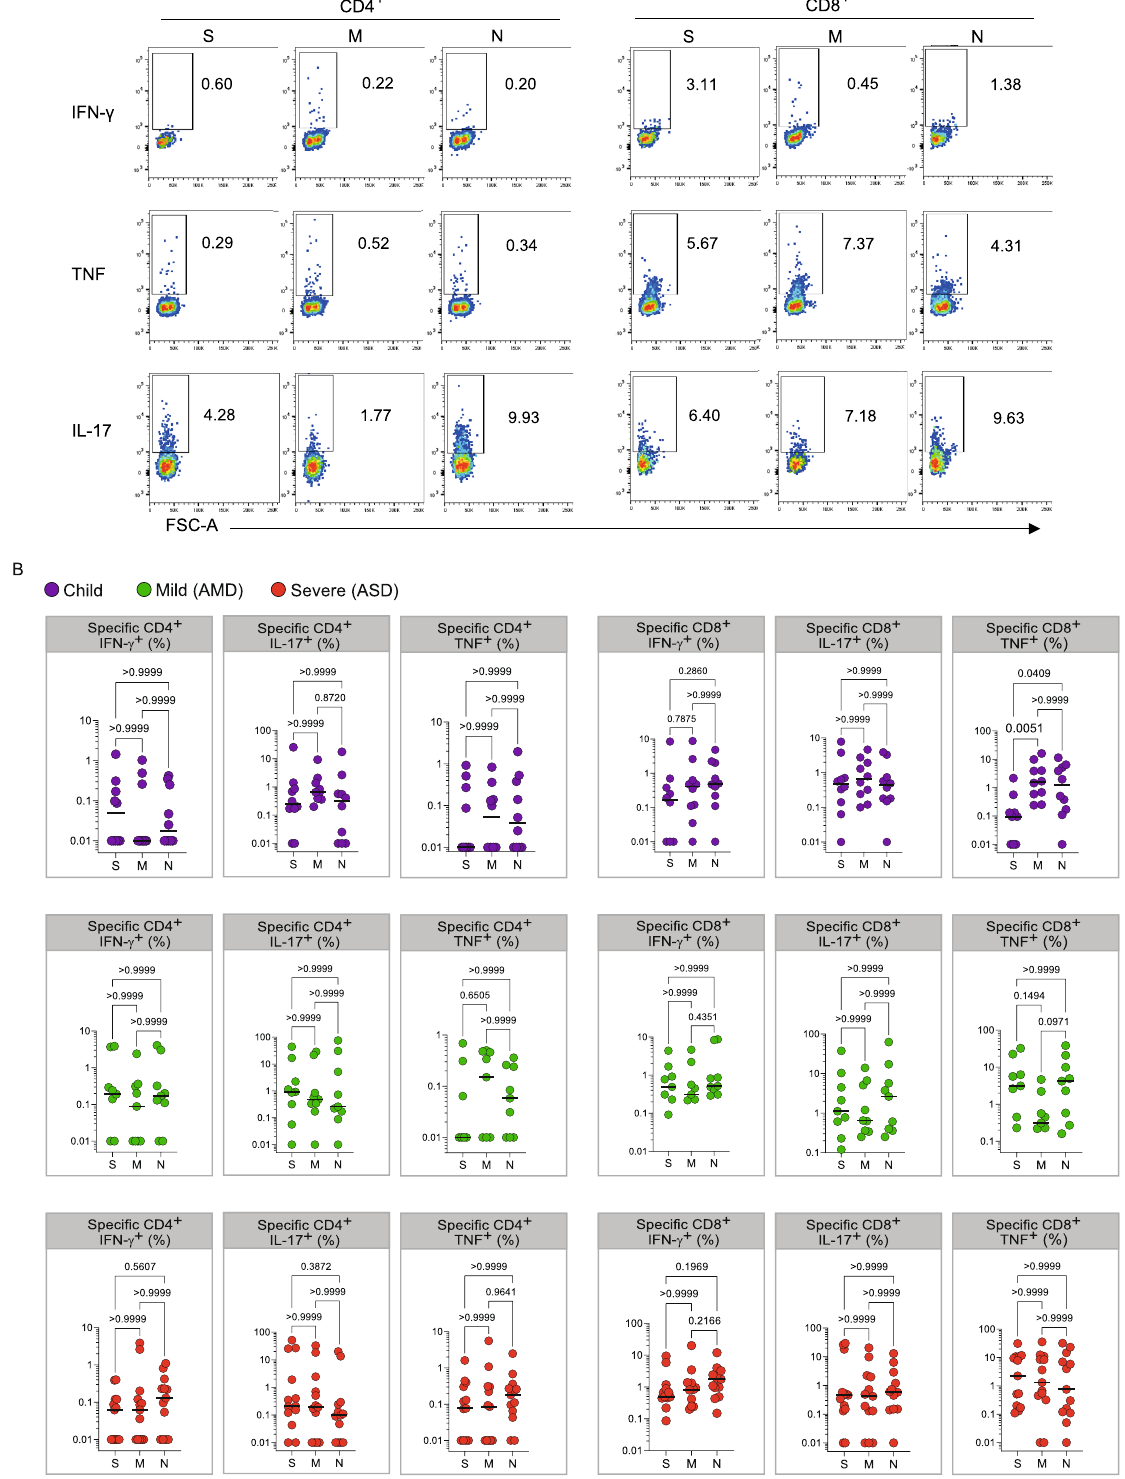
Fig. 5 Speci fi c T cell responses. A Gating strategies and typical plots of CD4 + and CD8 + T cells stimulated with peptide pools from structural proteins spike (S), membrane (M) and nucleocapsid (N), and analyzed by fl ow cytometry for cytokine production. B Comparisons of effector T cells in each group — percentages of CD4 + or CD8 + cells, producing IFN γ , TNF or IL-17 in response to stimulation by each peptide pool. Each dot represents a patient, color coded: purple for children; green for adults with mild disease and red for adults with severe disease. All analyses are Kruskal – Wallis tests, and the p values are indicated over brackets ( n children = 10, n AMD = 9, n ASD = 13). Signi fi cant differences are indicated by p values in a higher font, the horizontal bar representing the median. Source data are provided as a Source Data fi